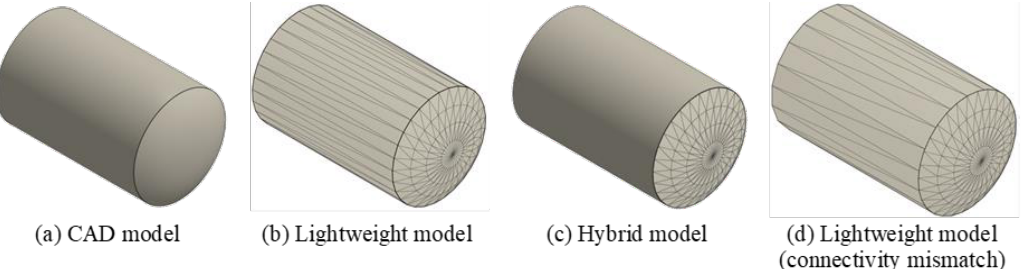
Figure 2. Various lightweight model types.